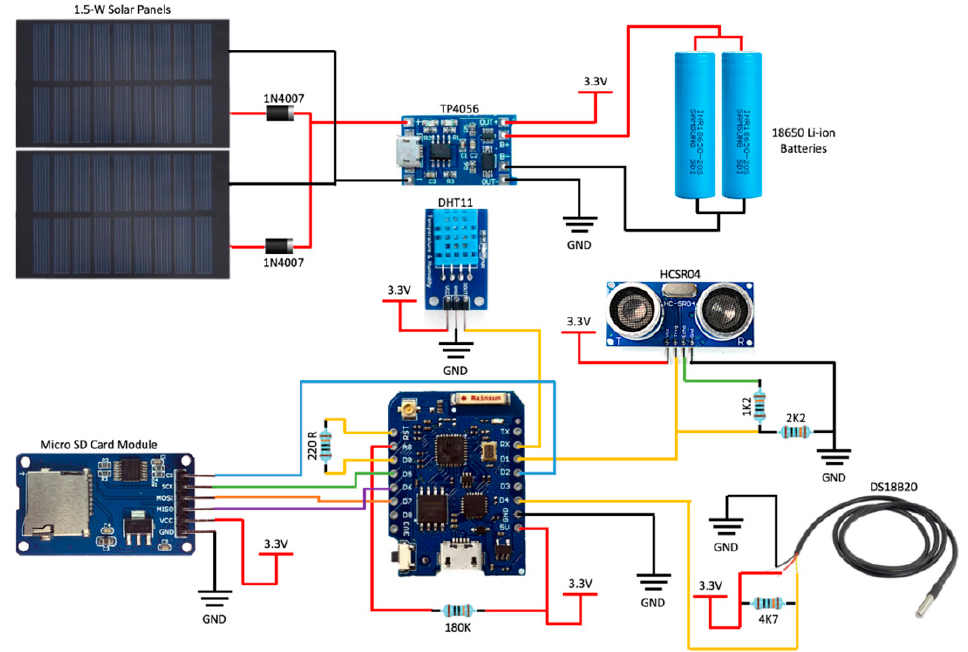
Figure 1. Wiring diagram of the low-cost wireless sensor modules with labeled electronic compo- nents.